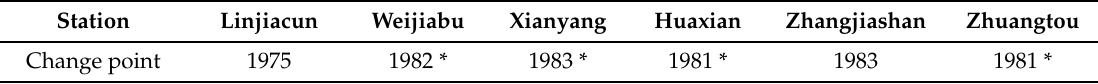
Table 4. Inflection points of runoff-sediment relationship at the six hydrological stations in the WRB. Station